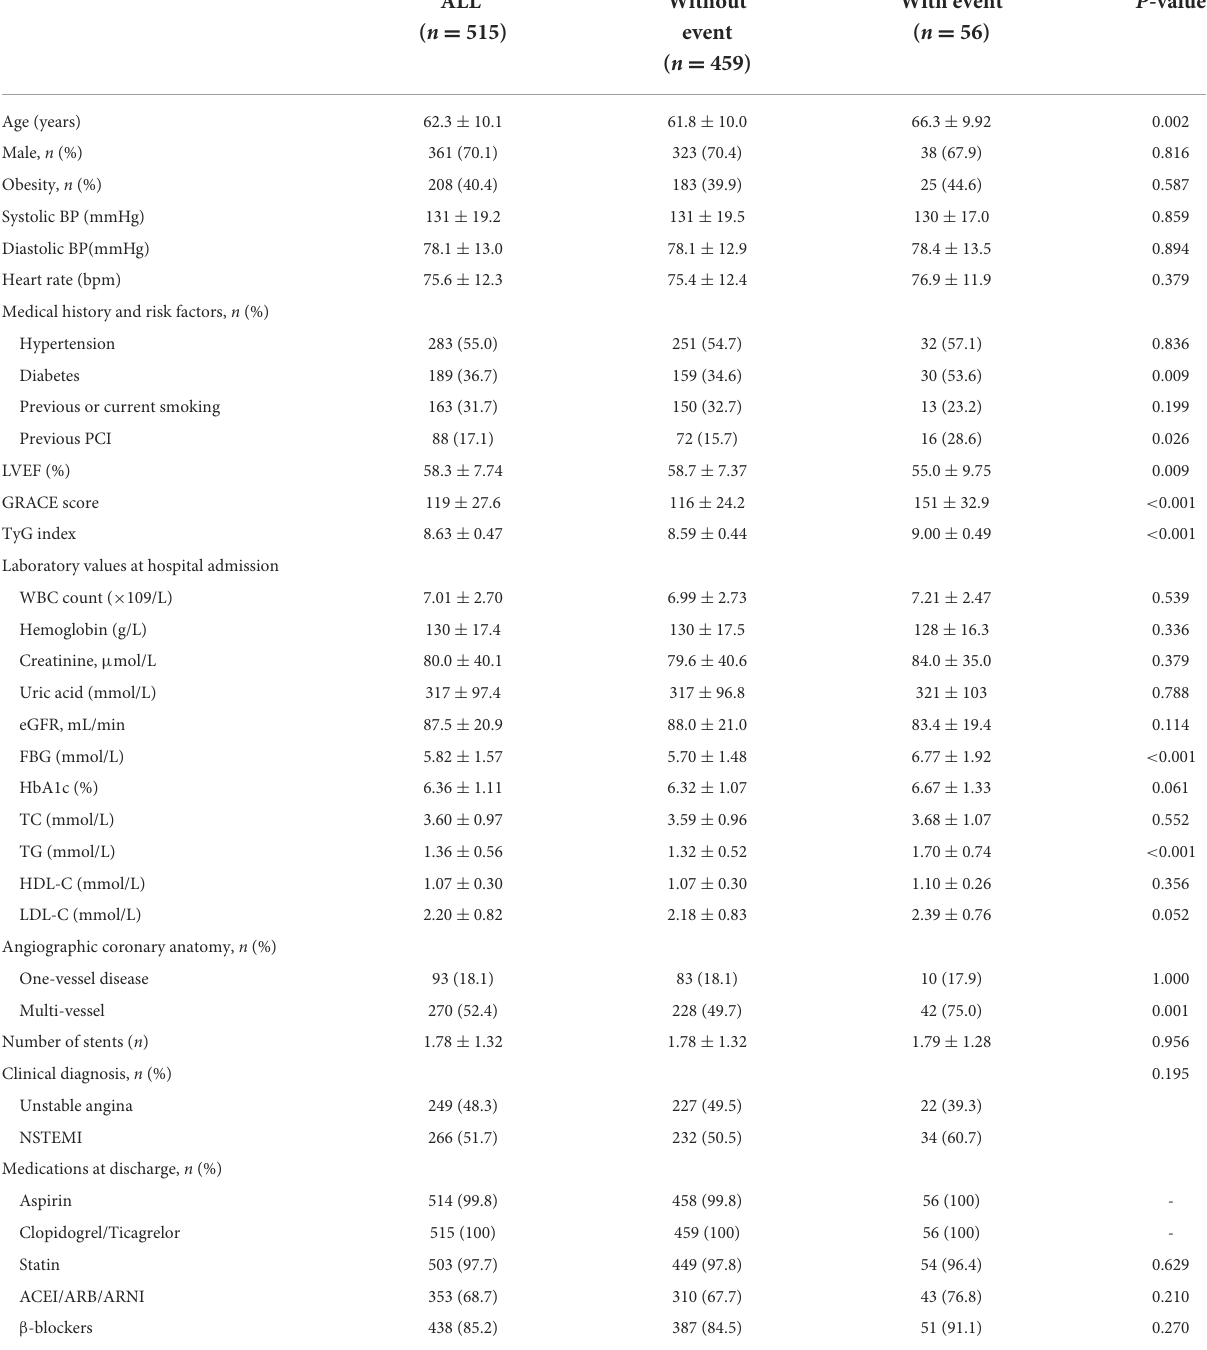
TABLE 1 Baseline characteristics of the study